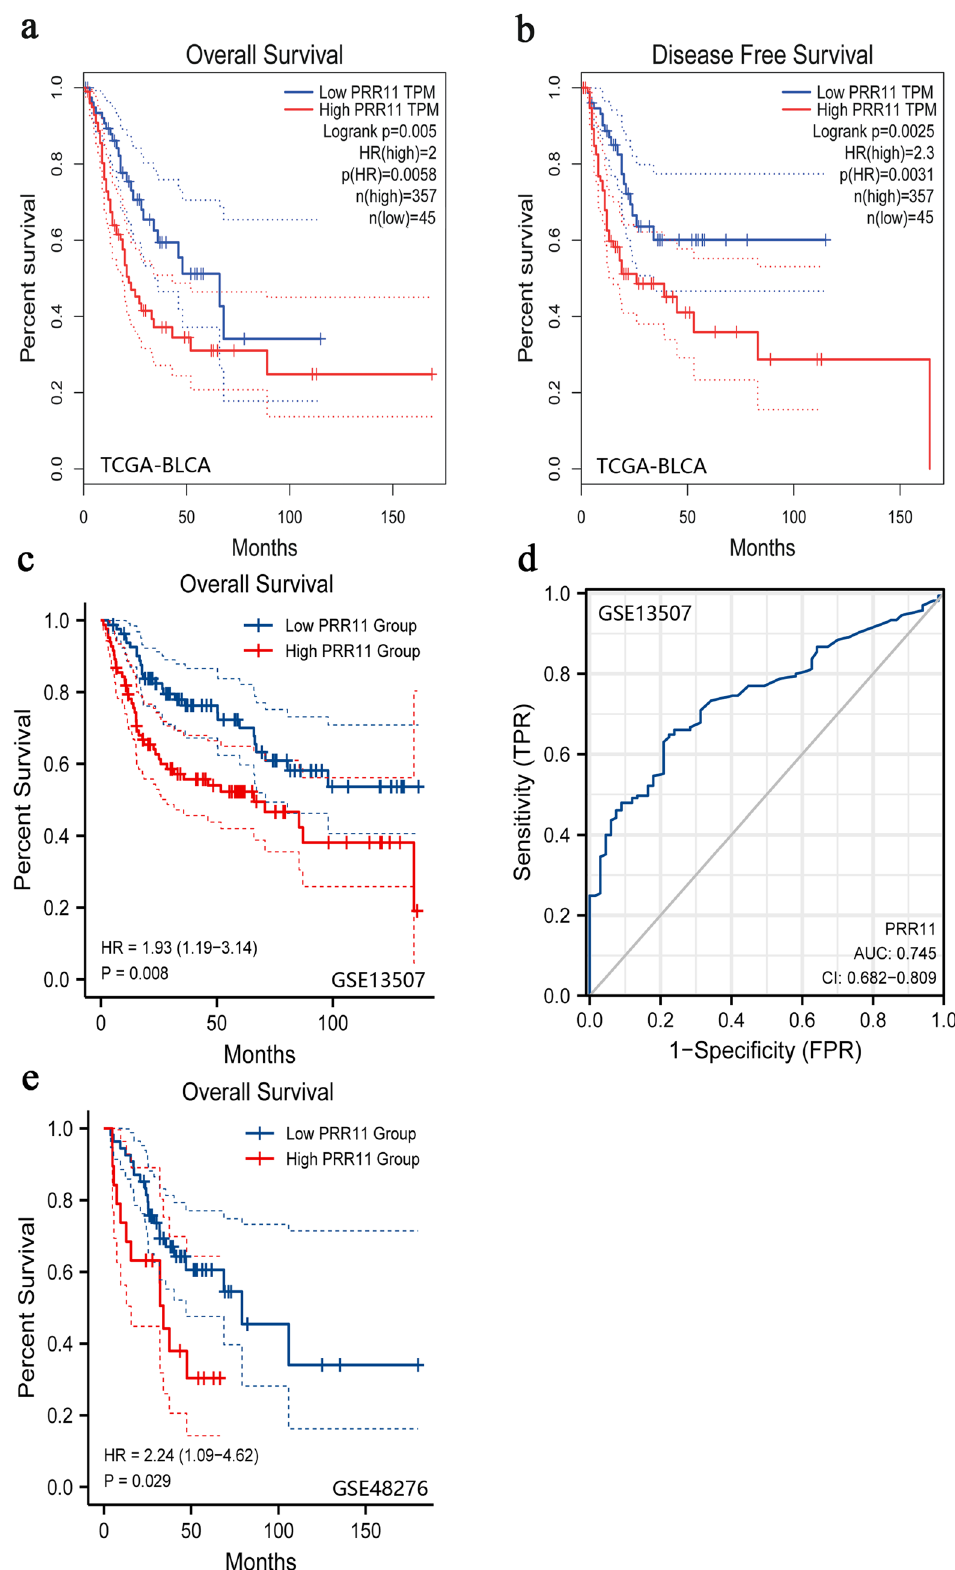
Figure 2. Kaplan ‐ Meier survival curves were used to analyze the correlation between gene alterations in PRR11 and OS, as well as the RFS of BLCA patients. In TCGA-BLCA dataset, high PRR11 expression was correlated with poor OS ( a ) and RFS ( b ). Patients with higher PRR11 expression level had higher OS time in the GSE13507 ( c ) and GSE48276 dataset ( e ). ( d ) ROC curve showed the efficiency of PRR11 expression level to distinguishing BLCA from non-tumor tissue in GSE48276 dataset. X-axis represents false positive rate, and Y-axis represents true positive